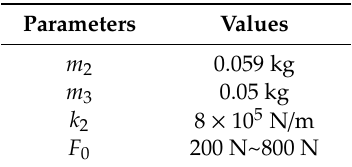
Table 6. The parameters of the system.